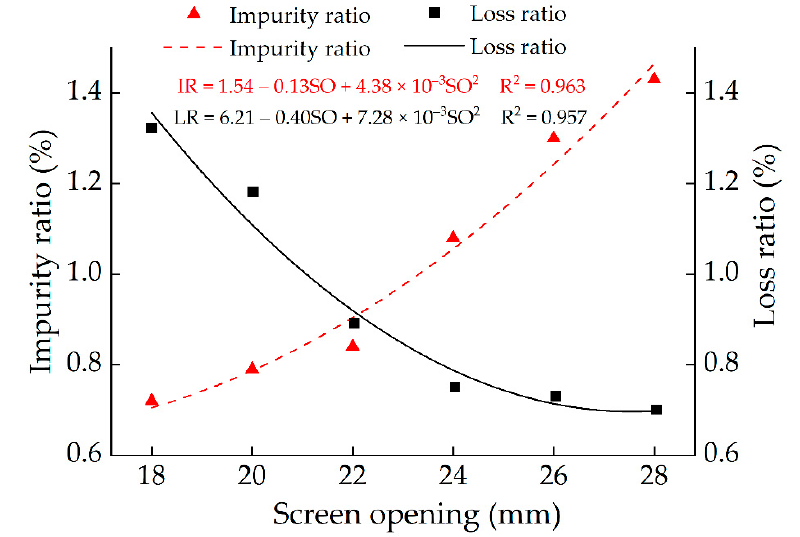
Figure 8. The influence of screen opening on the impurity ratio and the loss ratio.